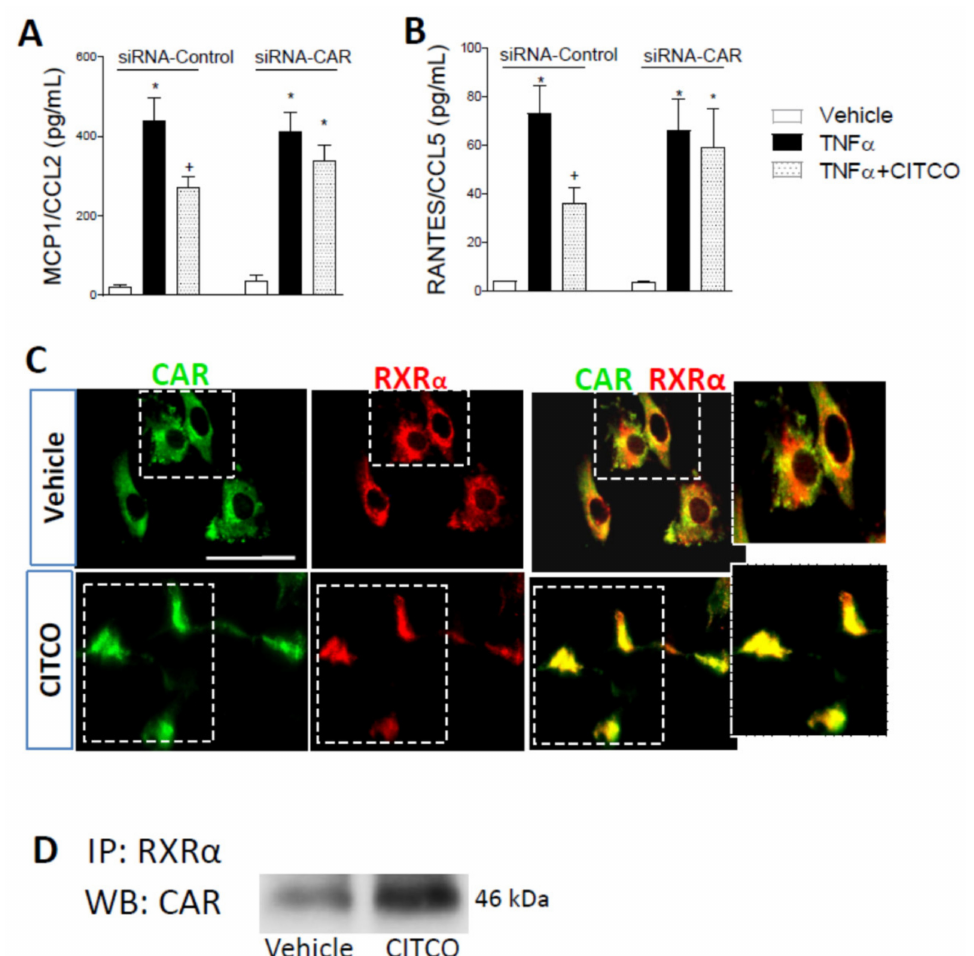
Figure 4. CITCO treatment reduced chemokine secretion in HUVEC. Endothelial cells were transfected with control or CAR-specific siRNA. At 48 h post-transfection, cells were pretreated with CITCO (3 µ M) for 24 h and then stimulated with TNF α (20 ng/mL, 24 h). ( A ) MCP-1/CCL-2 and ( B ) RANTES/CCL5 release was determined by ELISA in the cell-free supernatants of transfected HUVEC (values were expressed in pg/mL). Data represent mean ± SEM ( n = 5 independent experiments). * p < 0.05 relative to the respective vehicle group, + p < 0.05 relative to the respective TNF α -stimulated cells. ( C ) CITCO promotes CAR/RXR α interaction in HUVEC. Representative images of CAR and RXR α and after CITCO treatment. Immunoreactivity was visualized using Alexa Fluor 488 (CAR, green) and Alexa Fluor 594 (RXR, red) secondary antibodies. Bar = 50 µ m. ( D ) CAR/RXR α -interaction was assessed by immunoprecipitation. A representative blot is shown of n = 3 independent experiments. IP: immunoprecipitation. WB: Western